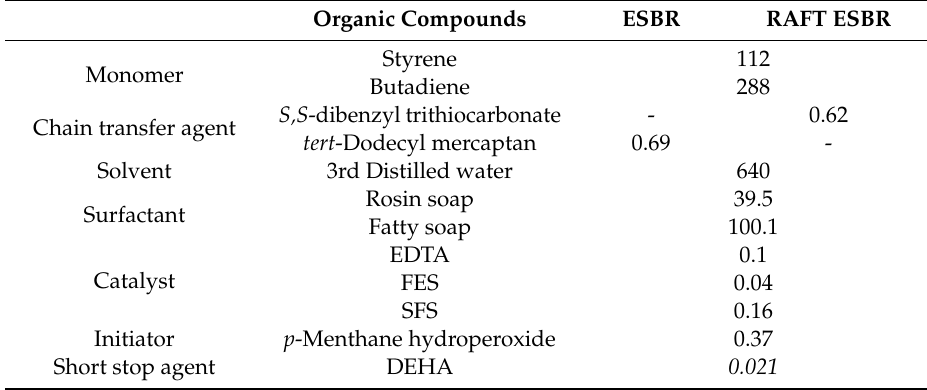
Table 1. Experimental formulation for the reversible addition-fragmentation radical transfer emulsion styrene butadiene rubber (RAFT ESBR) polymerization; (Unit: g). Organic